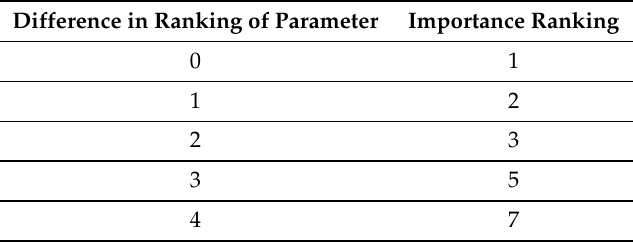
Table 13. Saaty scale based on the difference between number of plan irregularities. Difference in Ranking of